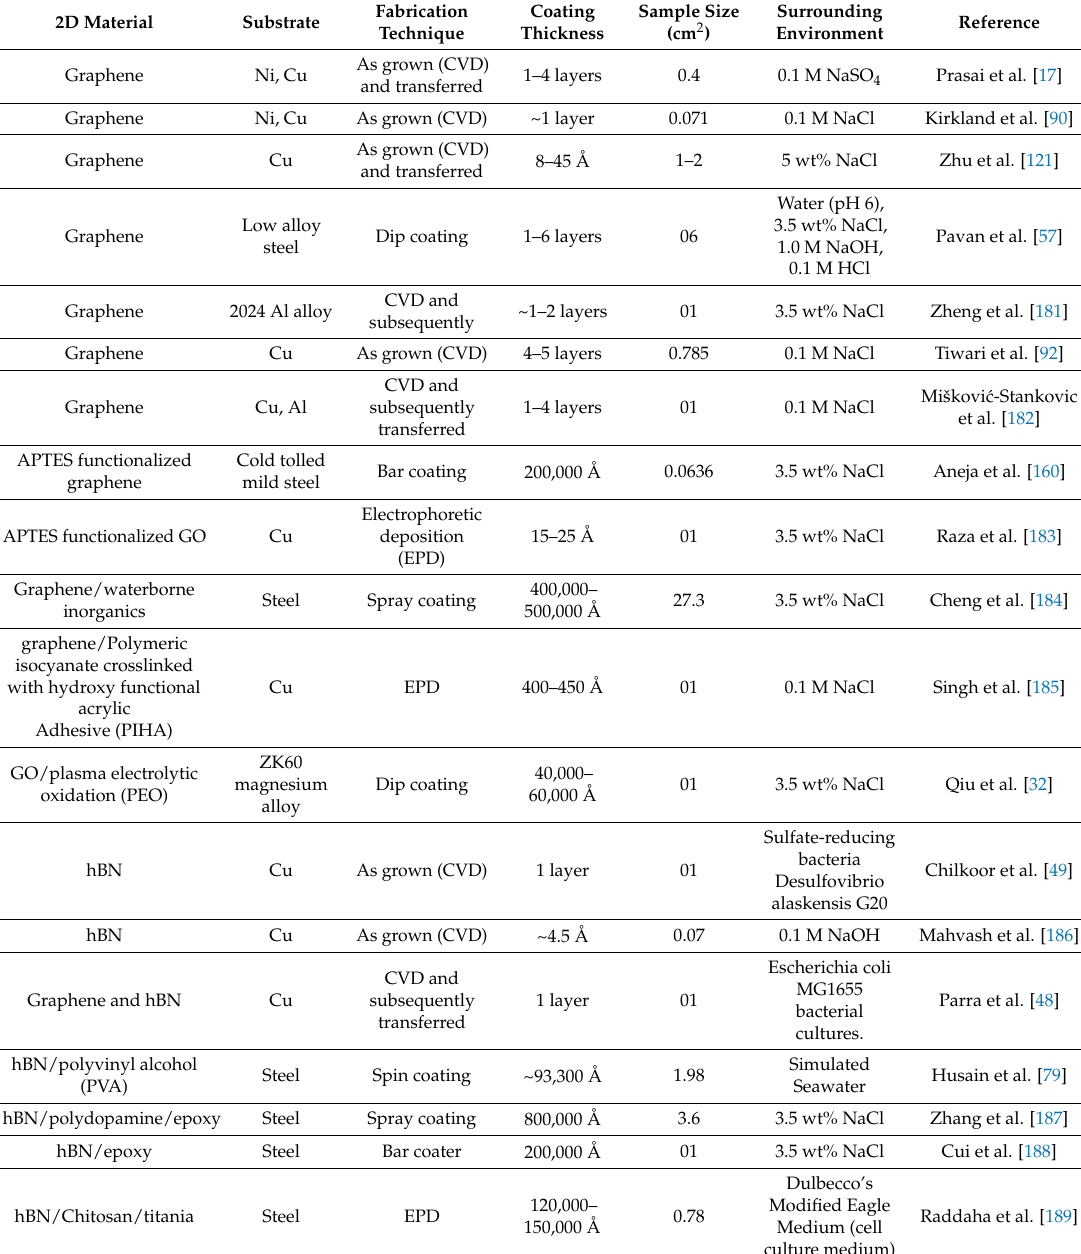
Table 4. Brief summary of different parameters of 2D material/metal system available in